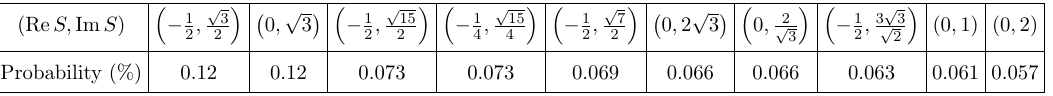
Table 7 . Probabilities of the stable vacua as functions of (Re S; Im S ) in the descending order of the probability for N max = 10. (cid:13)ux